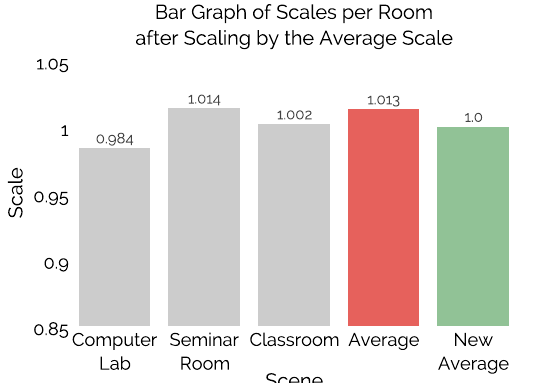
Figure 6: Bar graph illustrating the effect of applying the average scale to each